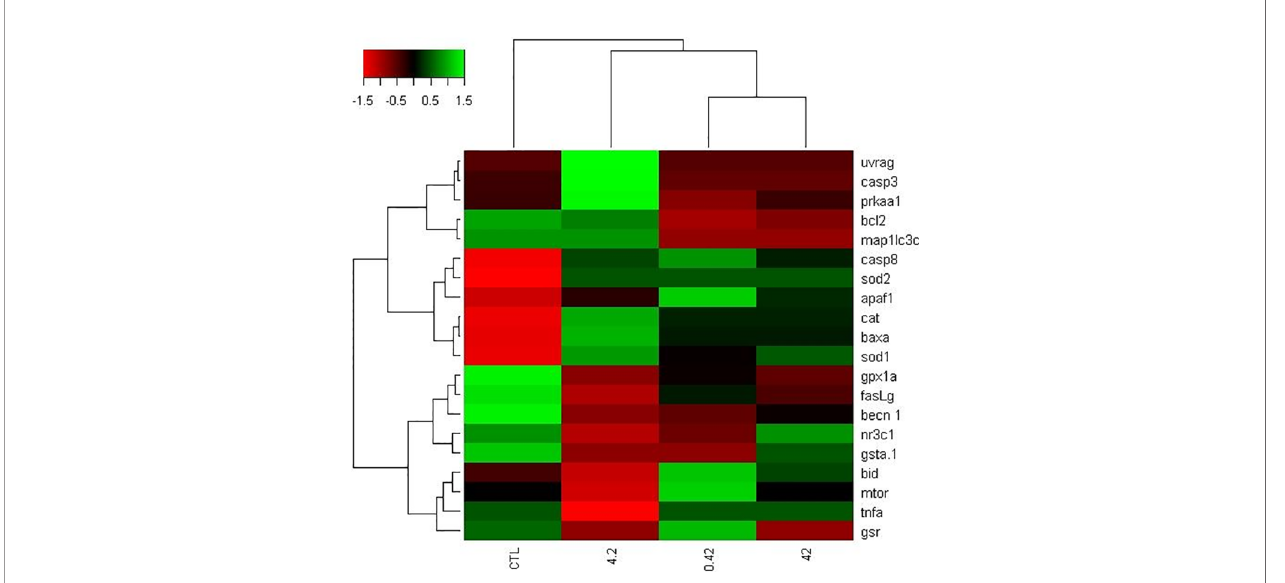
FIGURE 1 | Gene expression heatmap (autophagy, apoptosis and oxidative stress) from zebra fi sh ovaries exposed to DINP. Color code to represented upregulated genes (green) and downregulated genes (red). Both rows (genes) and columns (treatments) were grouped by hierarchical clustering.